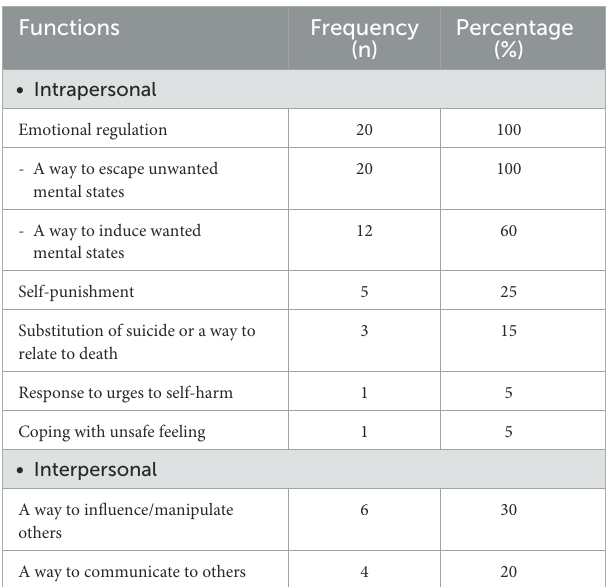
TABLE 4 Functions of intentional